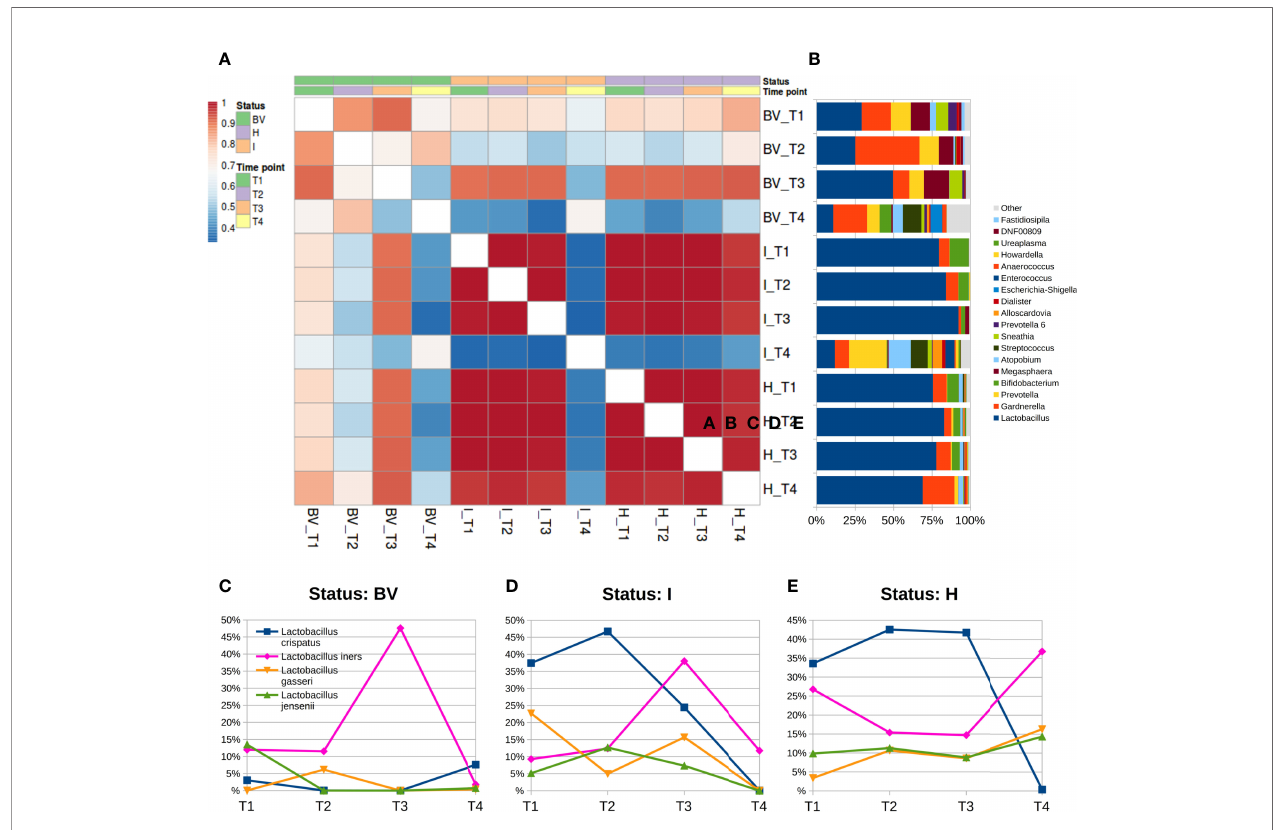
FIGURE 3 | Microbiota evolution during puerperium (T4). (A) Heatmap of Pearson ’ s correlation coef fi cients calculated between average relative abundances at genus level over time and strati fi ed for vaginal status; (B) barplots of average relative abundances at genus level over time and strati fi ed for vaginal status; genera with rel. ab. ≤ 1% were grouped in “ Others ” category; (C – E) Line plots of average abundances of Lactobacillus species over time. Only the four most abundant species are